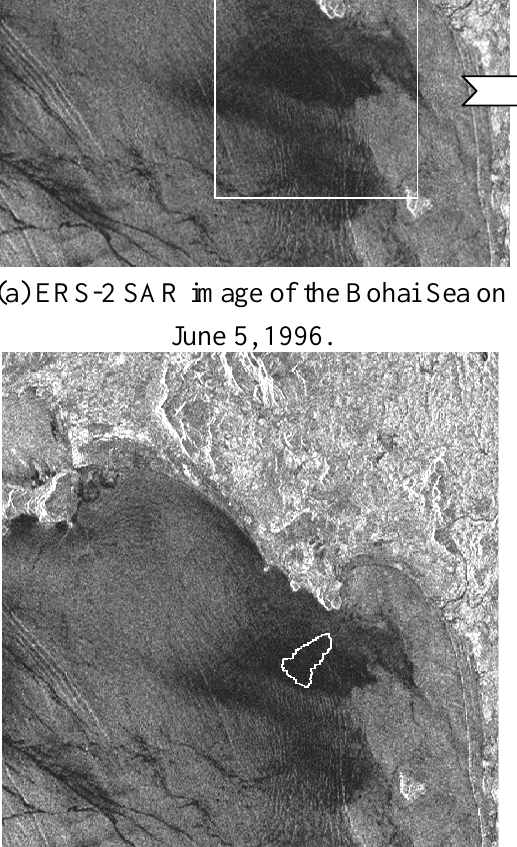
(d) An interface boundary expanding